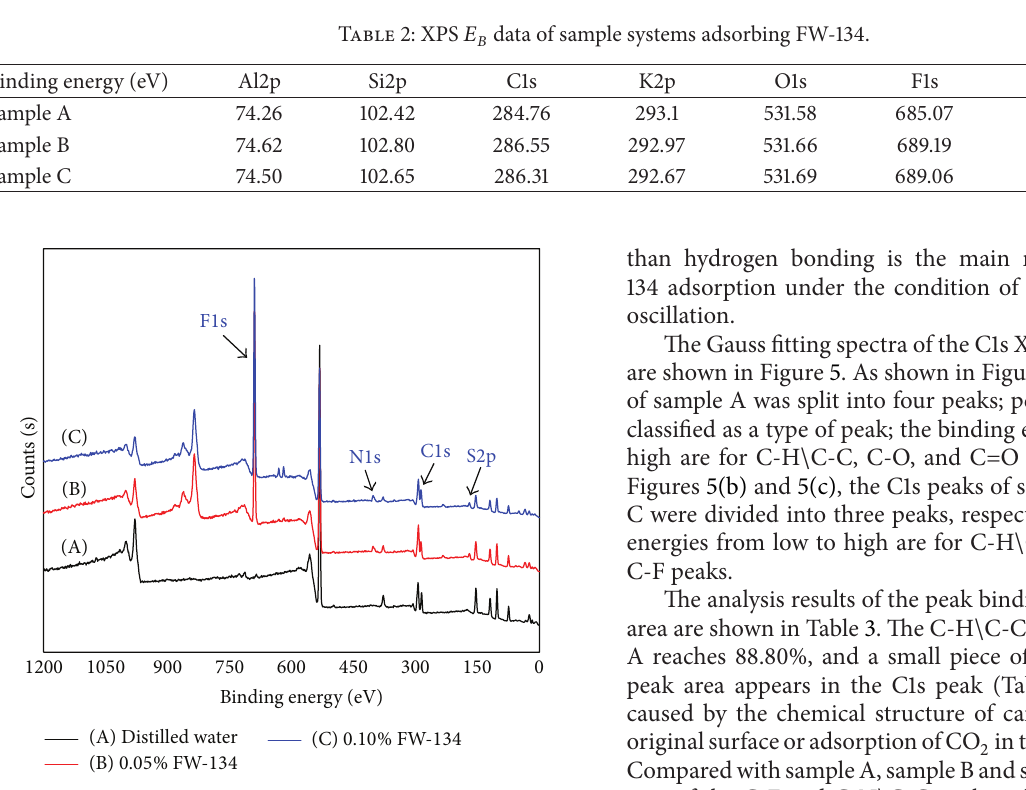
Figure 3: XPS spectra of sample systems adsorbing